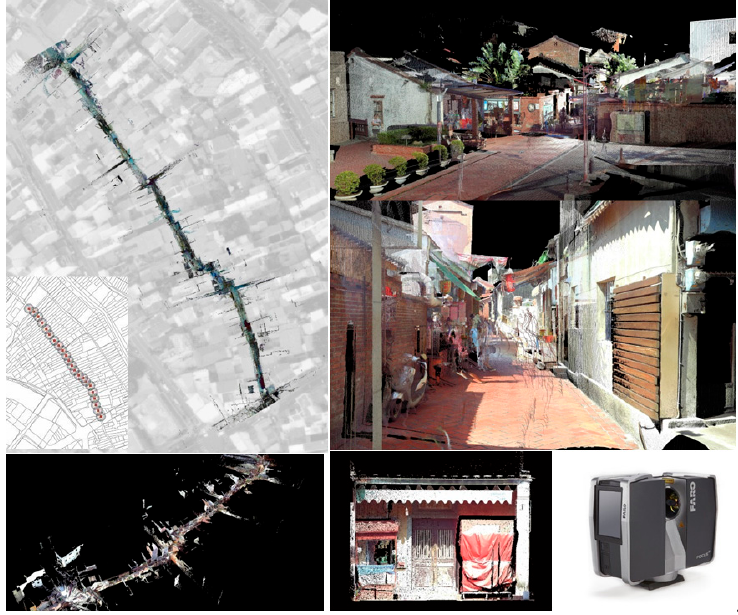
Figure 7. 3D scans of Old Street shops ( top , bottom left ) and applied Faro Focus 3D S120 ® scanner (Faro, Germany) ( bottom right ).